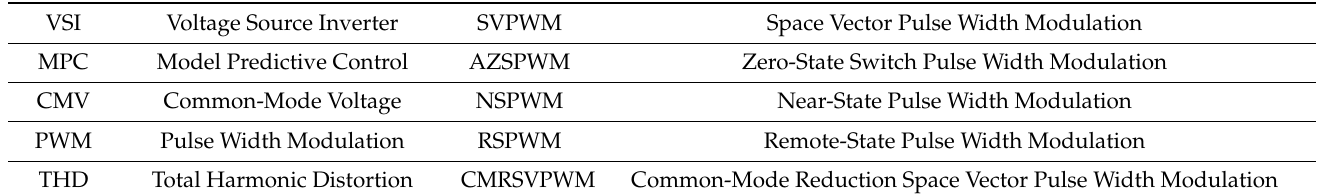
Table A1. Definition of acronym in